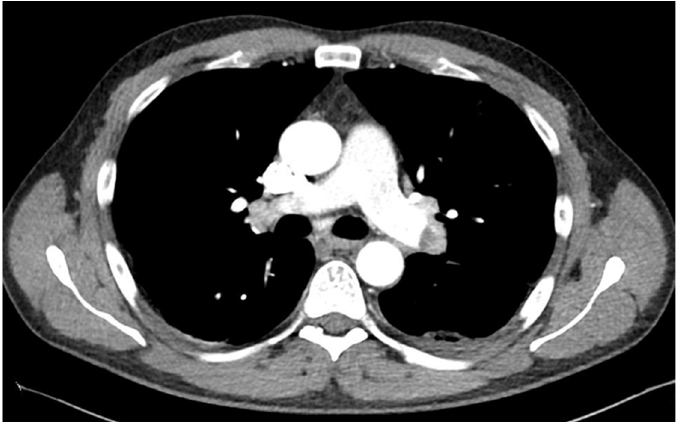
Figure 2. Thoracic computed tomography (CT) at day 9 after admission revealed a bilateral central pulmonary embolism.